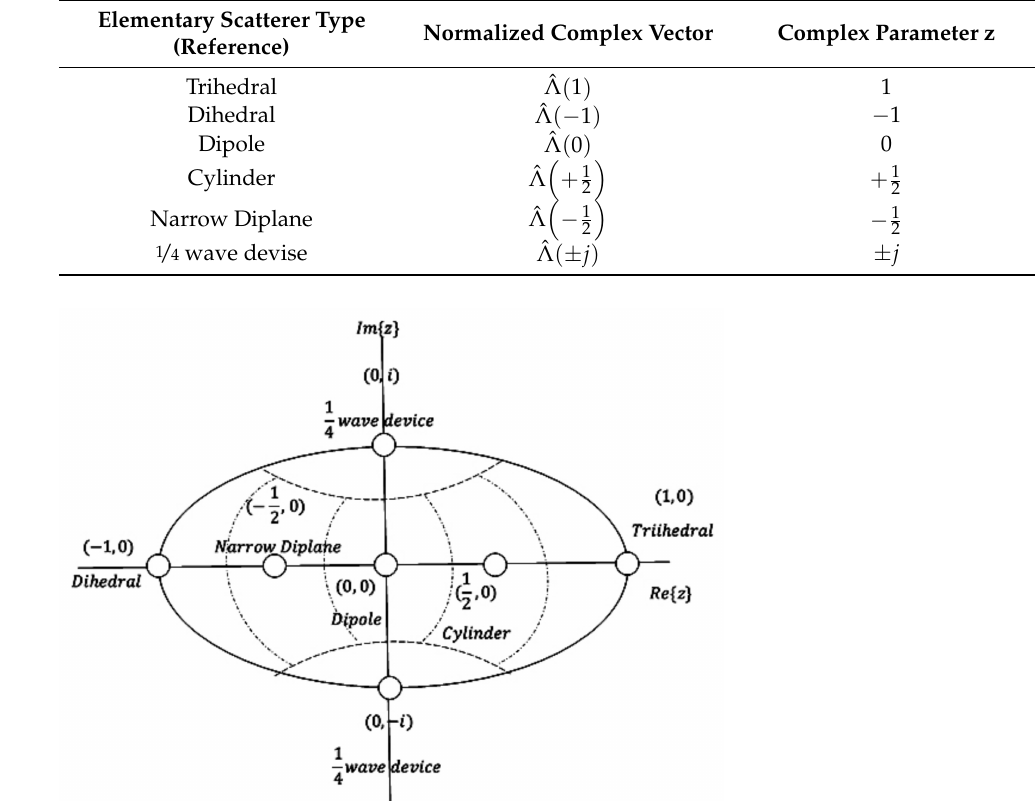
Table 1. Cameron’s scattering mechanisms.